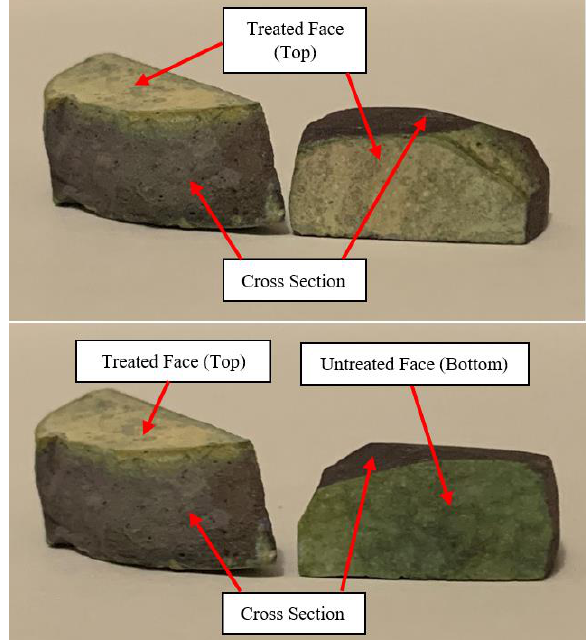
Figure 14. pH of 2Ti-MAH sample after cycle testing.